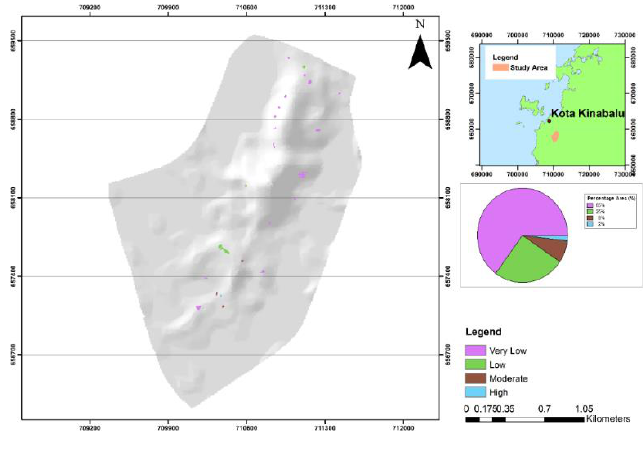
Figure 8: Social Vulnerability (Vs) Map